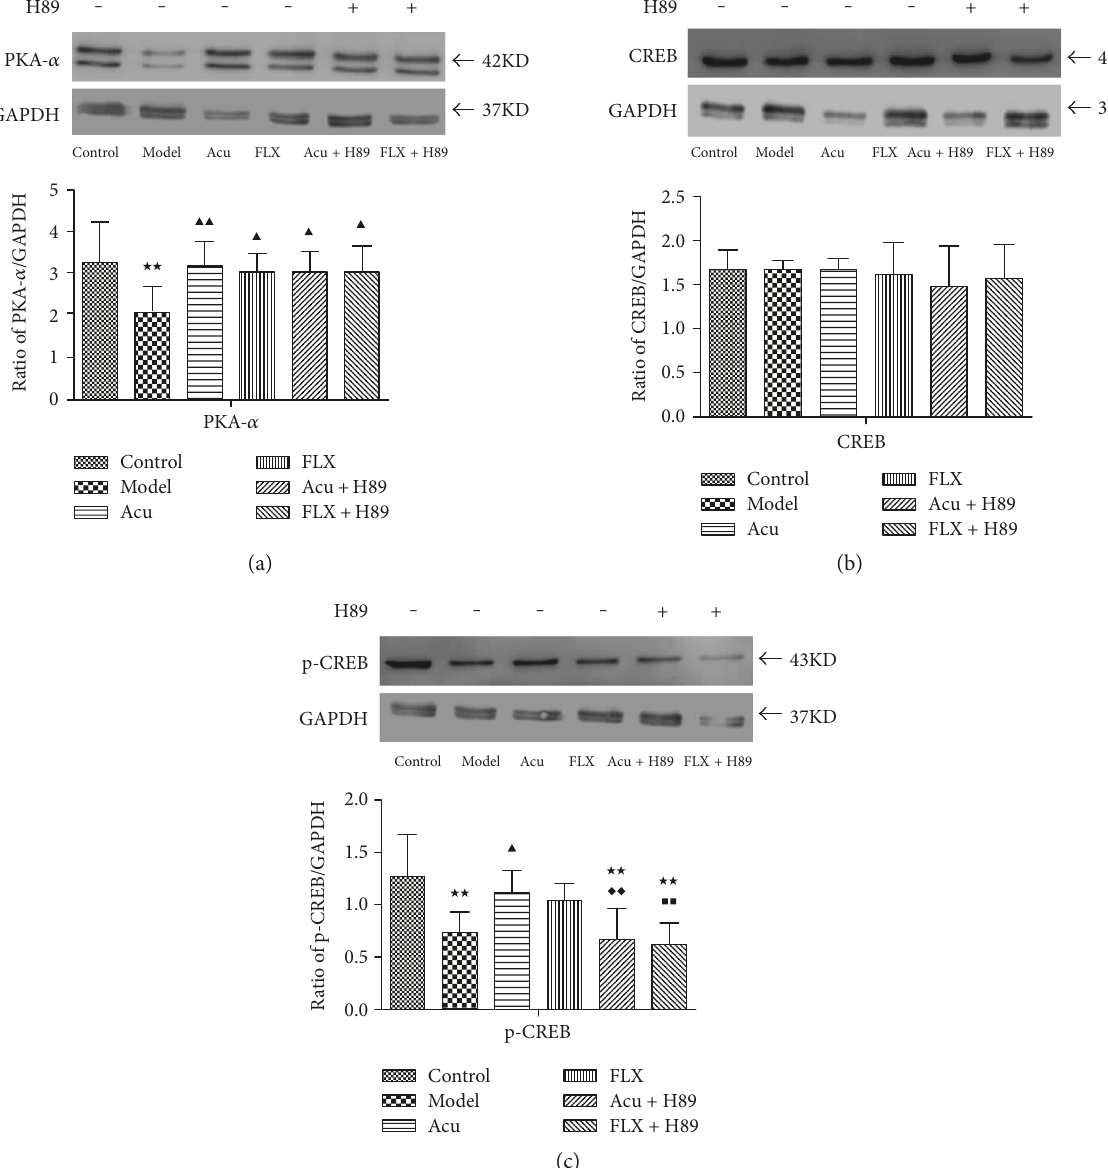
Figure 4: Di ff erences showing the e ff ects of stress/antidepressant treatments on the expression levels of hippocampal PKA- α , CREB, and p-CREB in depression rats induced by CUMS. (a) The e ff ects of stress/antidepressant treatments on the expression level of hippocampal PKA- α in depression rats induced by CUMS. (b) The e ff ects of stress/antidepressant treatments on the expression level of hippocampal CREB in depression rats induced by CUMS. (c) The e ff ects of stress/antidepressant treatments on the expression level of hippocampal p- CREB in depression rats induced by CUMS. Di ff erences are shown as follows: ★★ P < 0 01 versus control group; ▲ P < 0 05 versus model group; ▲▲ P < 0 01 versus model group; ◆◆ P < 0 01 versus acupuncture group; ■■ P < 0 01 versus fl uoxetine group. Results are presented as x ± s for 10 rats in each group. Acu: acupuncture group; FLX: fl uoxetine group; Acu+H89: Acupuncture +H89 group; FLX+ H89: Fluoxetine+ H89 group; PKA- α : protein kinase A- α ; CREB: cyclic adenosine monophosphate response element-binding protein; p-CREB: Phosphor-CREB; GAPDH: glyceraldehyde-3-phosphate